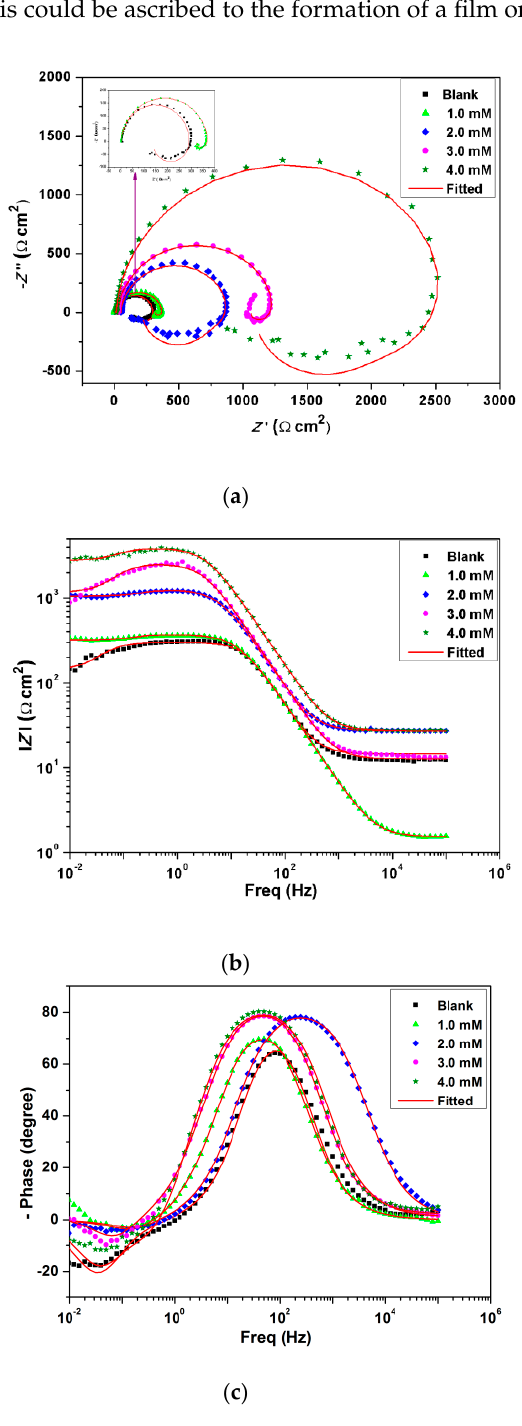
Figure 5. Impedance plots of the of AA 6061 corrosion in 1 M HCl without and with different concentrations of inhibitor at 303 K, ( a ) Nyquist Plots, ( b ) Bode modulus plots, ( c ) Bode phase plots. The values of the impedance parameters are recorded in Table 3. The fitted data are in good agreement with the experimental data, as evidenced by their low χ 2 values. Both R ct and R p values increased significantly with the addition of BMIm, indicating that the metal exhibited less corrosion in the presence of the inhibitor. The drop in CPE values with increasing inhibitor concentrations compared with the CPE values in blank solution may have been due to a reduction in local dielectric